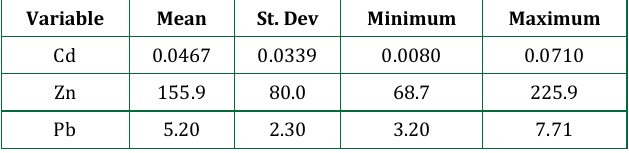
Table 4: Descriptive Statistical Analysis of Estimated Values of Cd Contaminant Level (mg kg) in Female Samples